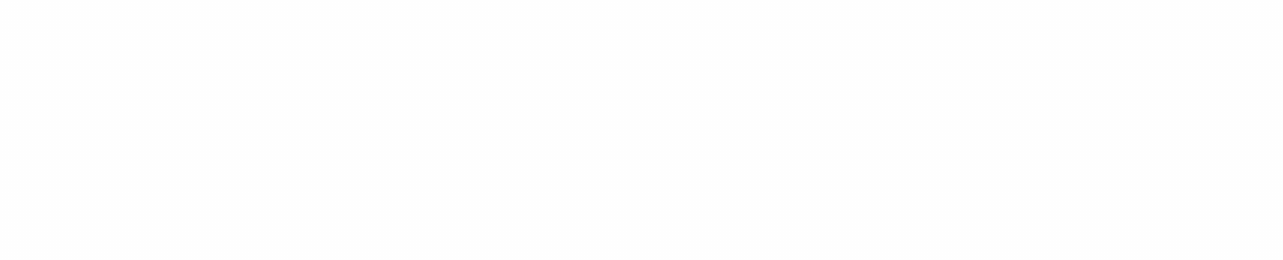
Fig. 5: CIPL length during the probe trial of the spatial version of the Morris swim task plotted relative to the EPSP amplitude (elicited at the 150 stimulus intensity). Young rats (O):no significant regression of behavior and EPSP amplitude; old rats (): significant regression between accuracy of spatial performance and the Schaffer collateral- CA1 synaptic response amplitude (a reflection of functional synaptic